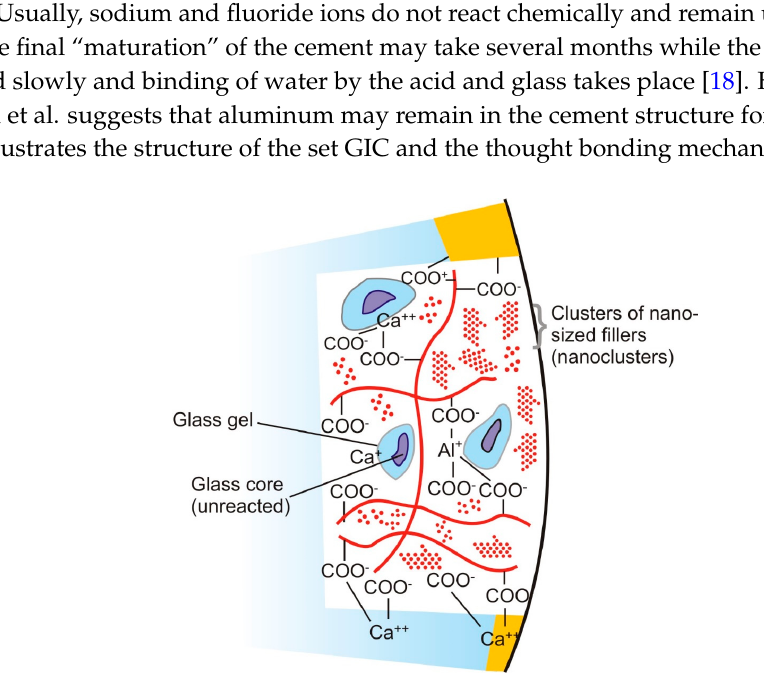
Figure 2. The structure of set glass ionomer cement and mechanism of bonding with tooth structure. The structure consists of unset glass particles which are ionically bonded to the cross-linked polyacrylate matrix via a gelation reaction. Bonding is achieved by the ionic interaction of the carboxylate groups (-COO − ) with the apatite crystals present in the tooth structure. In nano-filled ionomers, clusters of nano-sized fillers or bioceramics can be present embedded in the cement matrix.